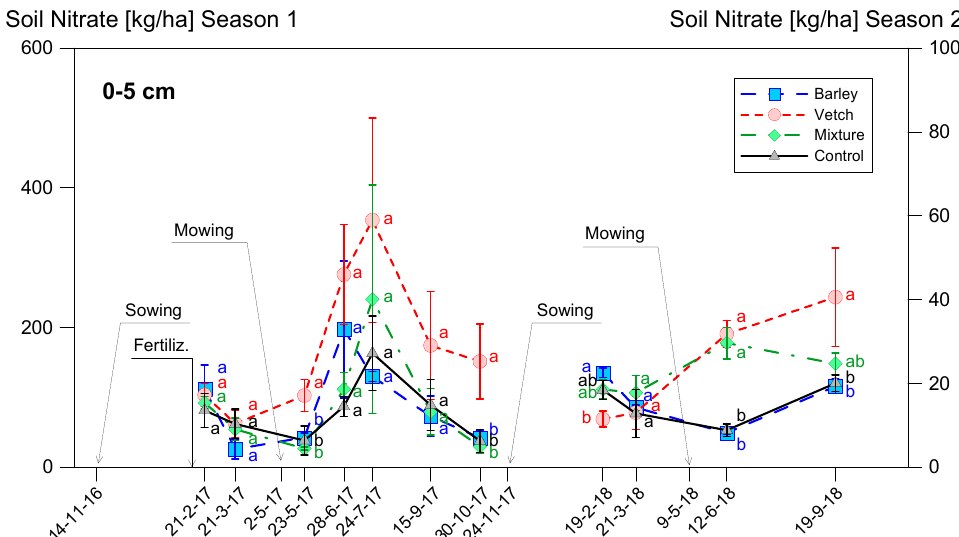
Figure 5. Soil nitrate content at 0–5 cm soil depth during the two-monitoring seasons. Vertical bars represent standard error. Different letters in each measuring date are statically different based on the LSD test ( p ≤ 0.05). X units follows the format DD-MM-YY. In the next second season, only vetch and mixture levels augmented the soil nitrate contents after mowing, although barley and control plots enhanced them later. At the end of the decomposition period, the vetch plot showed the highest value for both seasons and